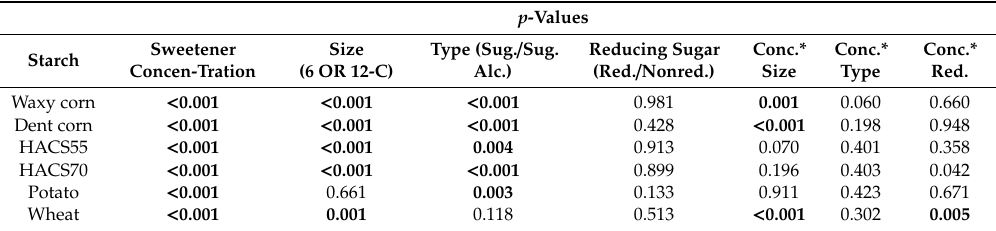
Table 4. Comparisons of correlation coe ffi cients (R) of slopes of log T gel vs. sweetener concentration (abbreviated log T gel in table) and ∆ T gel( i- 0) s in solutions of 3 M monosaccharide unit